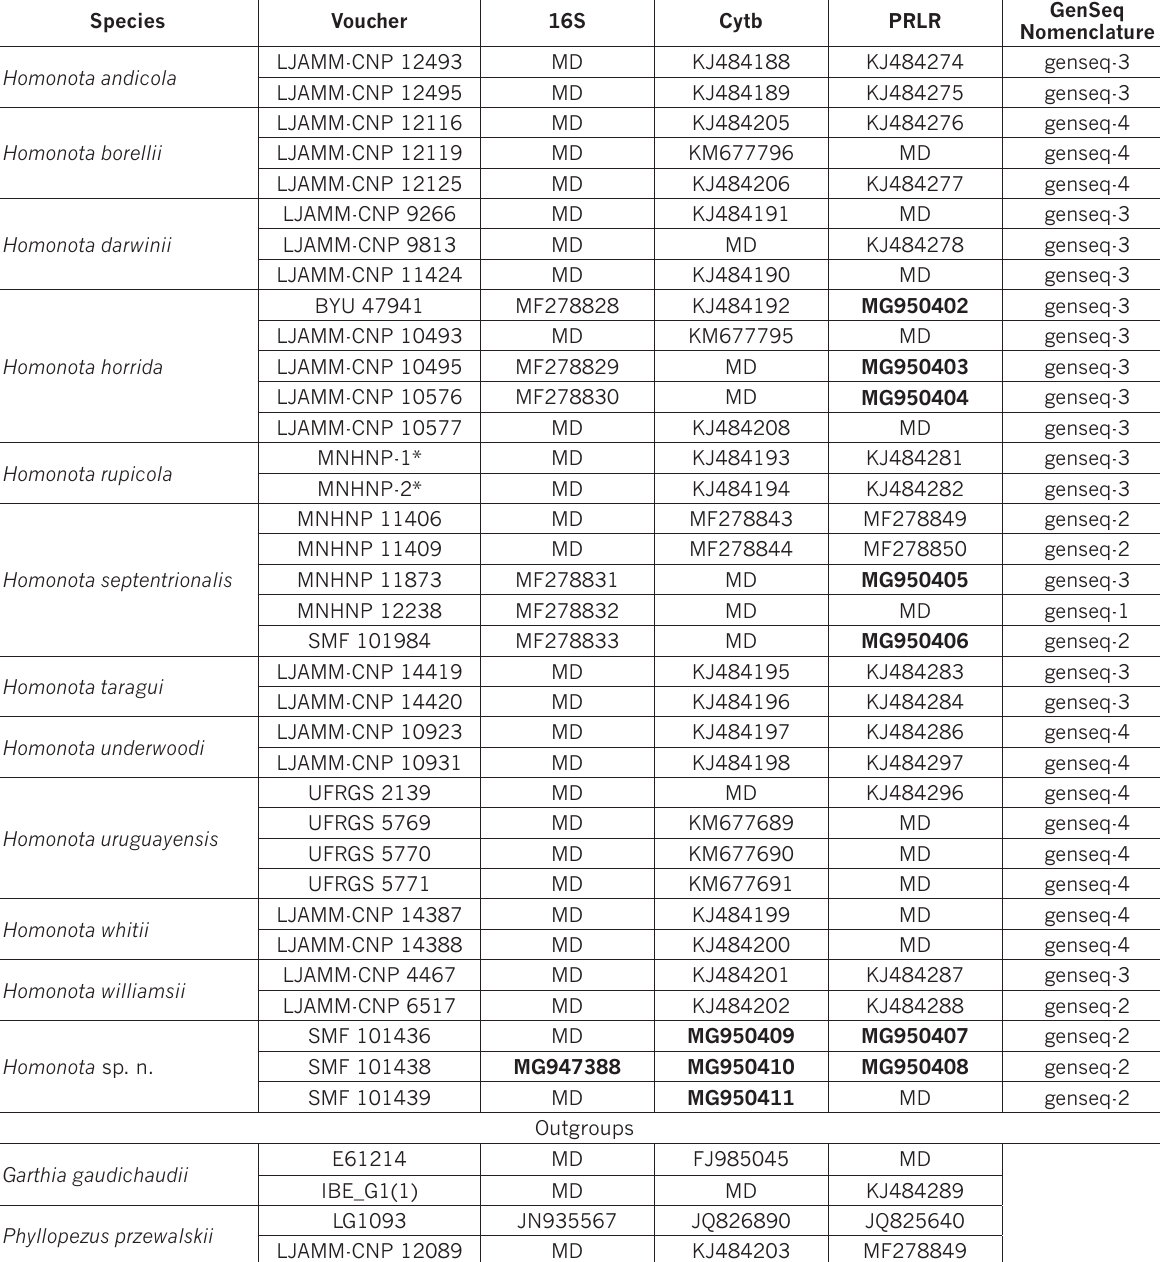
Table 1. Specimens used for genetic analyses and GenBank accession numbers for every gene. Asterisks (*) indicate tissue samples without voucher. Numbers in bold are samples generated for this